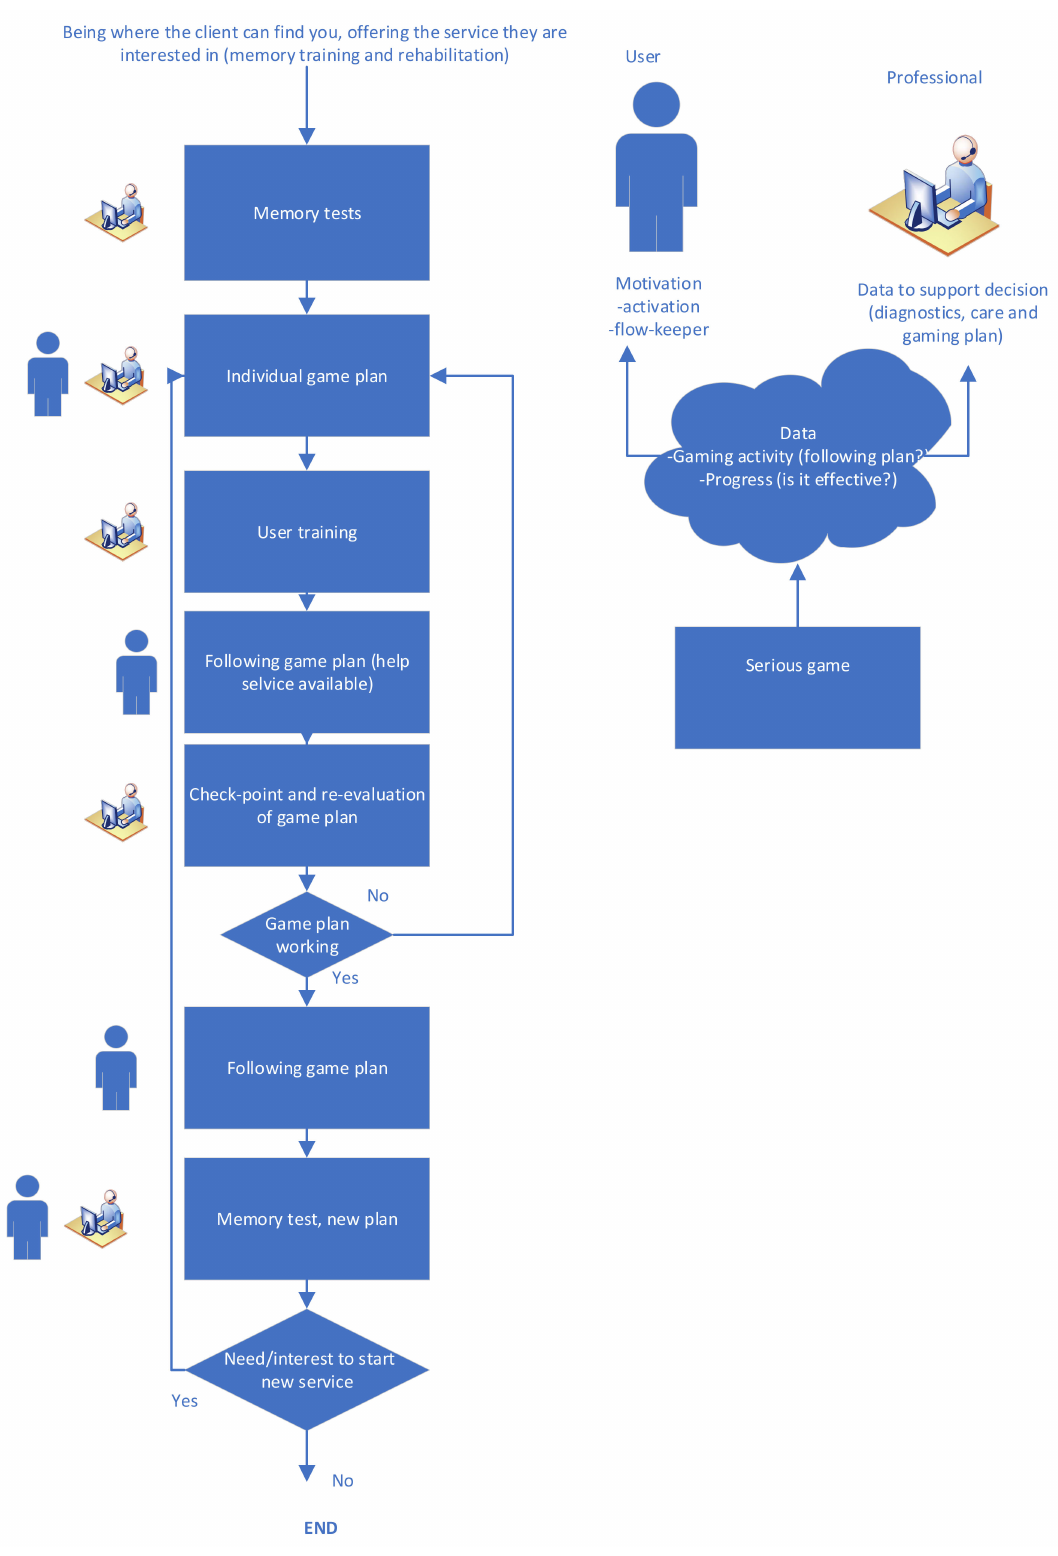
Figure 6. Service Model 1, based on the Finnish